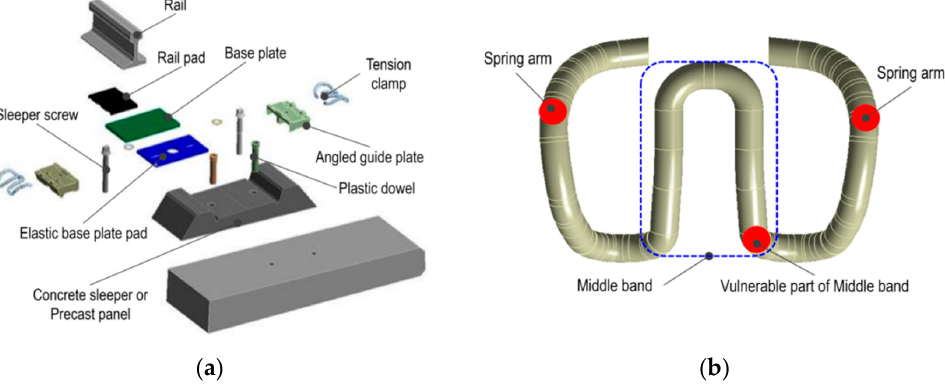
Figure 2. Schematic of elastic rail fastening system. ( a ) Components of elastic rail fastening system. ( b ) Main parts of tension clamp.